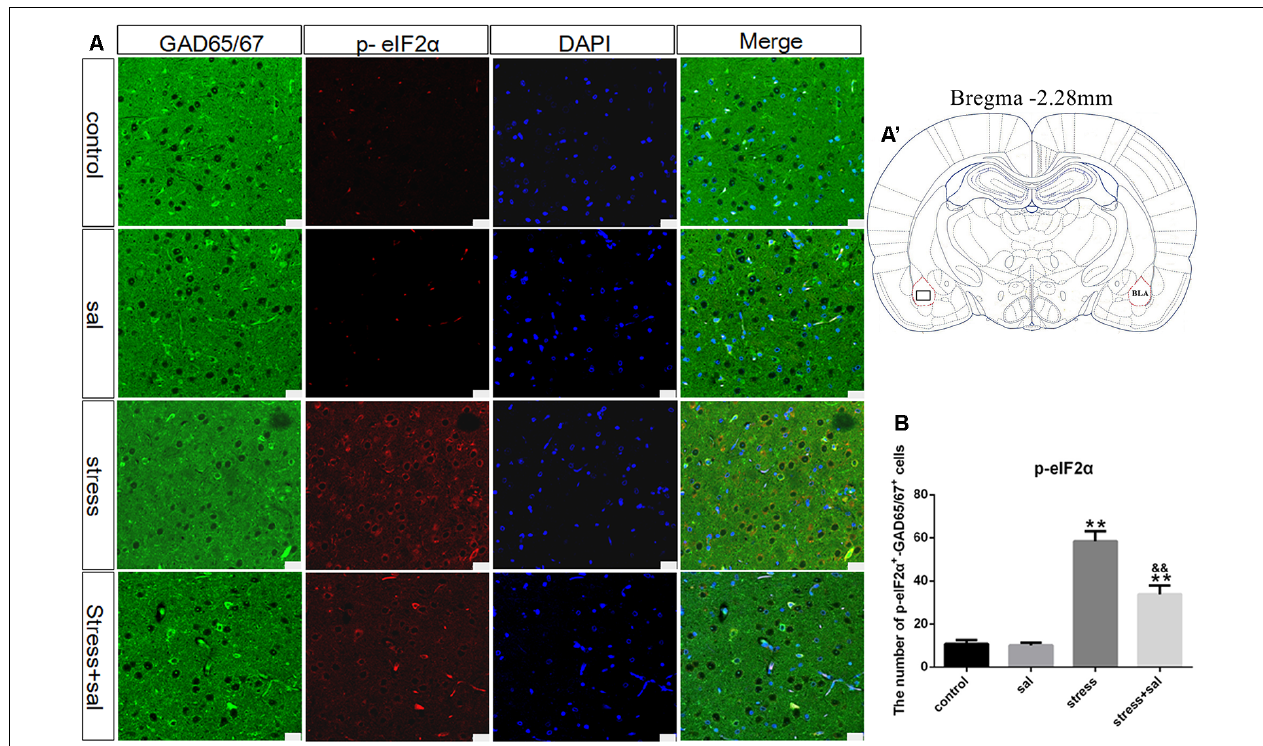
FIGURE 6 | Number of GAD65/67 positive neurons expressing p-eIF2 α in the BLA. (A) Representative confocal images showing coronal sections of rat immunostained for GAD65/67 (green), p-eIF2 α (red), DAPI (nuclear stain, blue) and merged (orange/yellow). Bars = 25 µ m. The analyzed region within the BLA is schematically illustrated in (A (cid:48) ) (diagram modified from Paxinos and Watson, 2007). (B) Quantitative analysis of the number of p-eIF2 α + -GAD65/67 + cells (one-way ANOVA). Data are shown as mean ± SEM, ∗∗ P < 0.01 vs. control group, && P < 0.01 vs. stress group ( n =